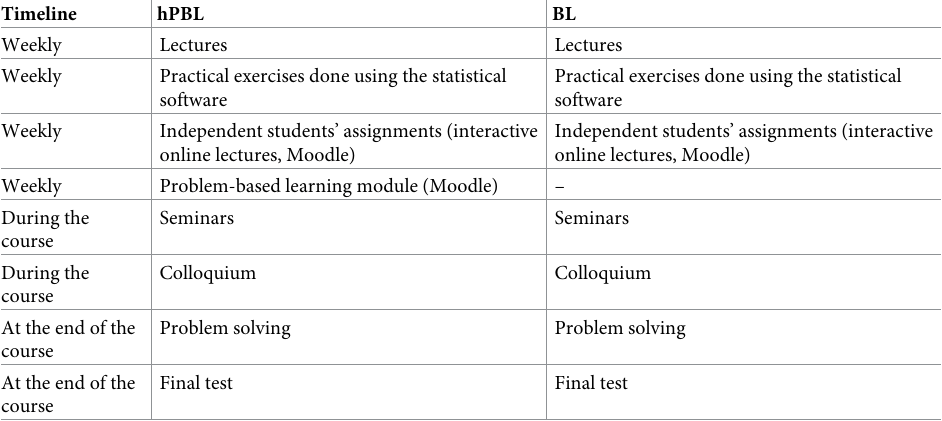
Table 1. Activities during medical statistics and informatics